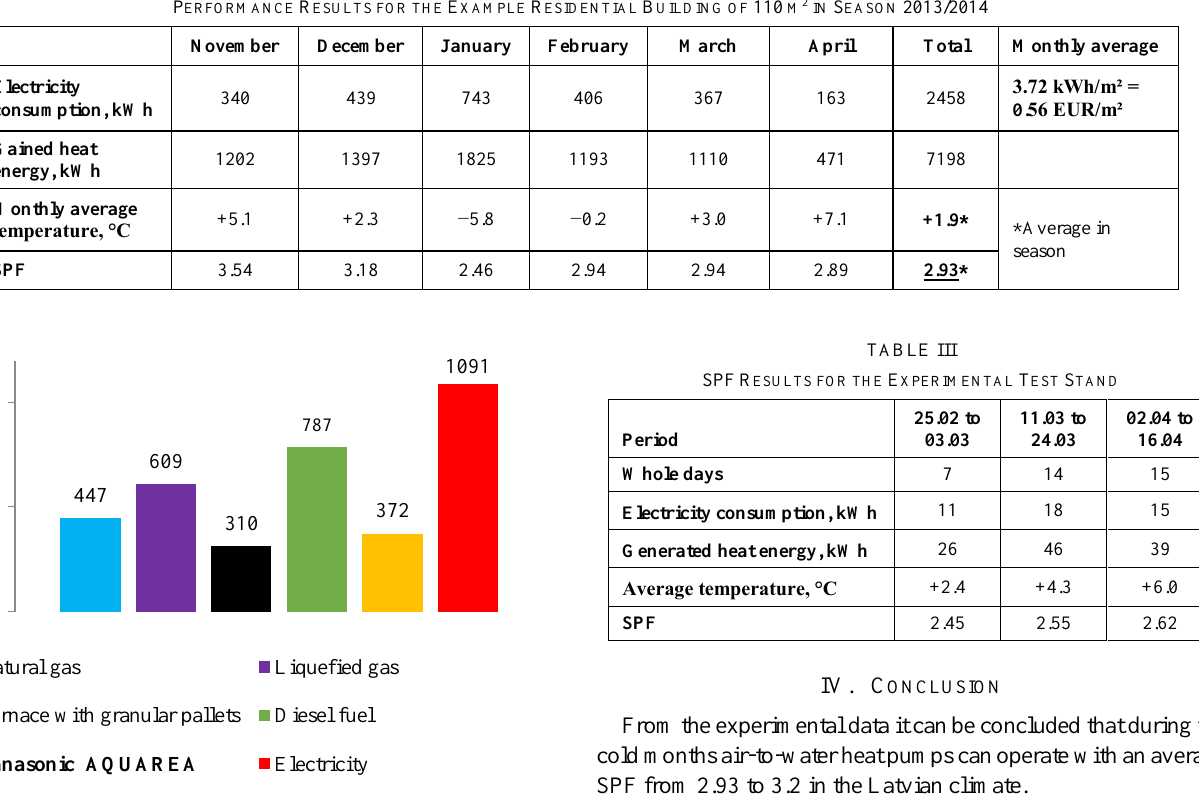
Fig. 5. Cost comparison of heat pump and other heating systems for 110 m 2 building in season